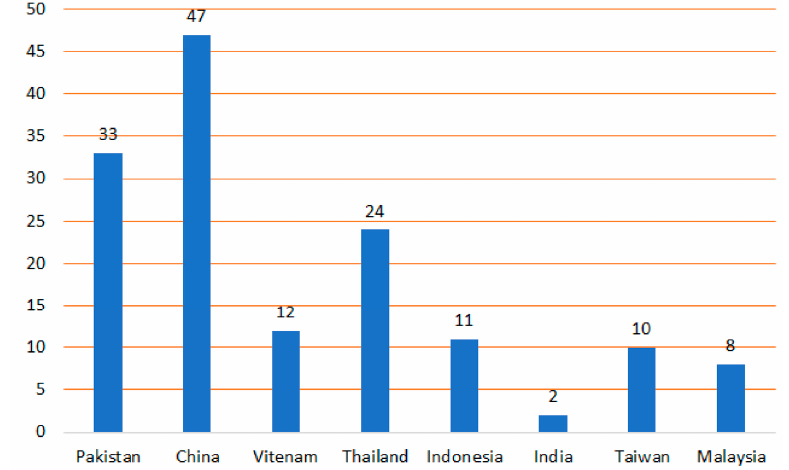
Figure 15. Number of reported metabolites from P . indica from various